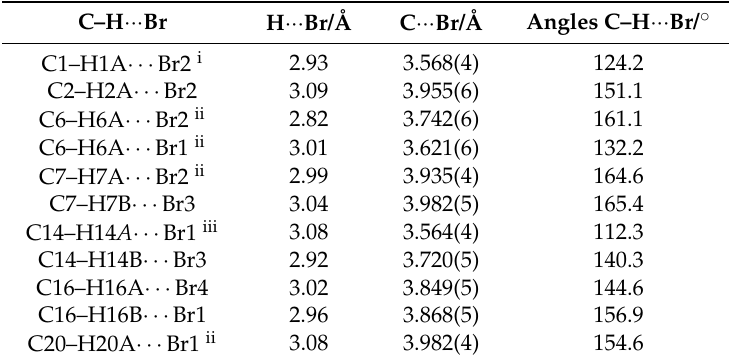
Table 3. Hydrogen contacts for (BzlEt 3 N) 2 [CuBr 4 ] ( 5 ).